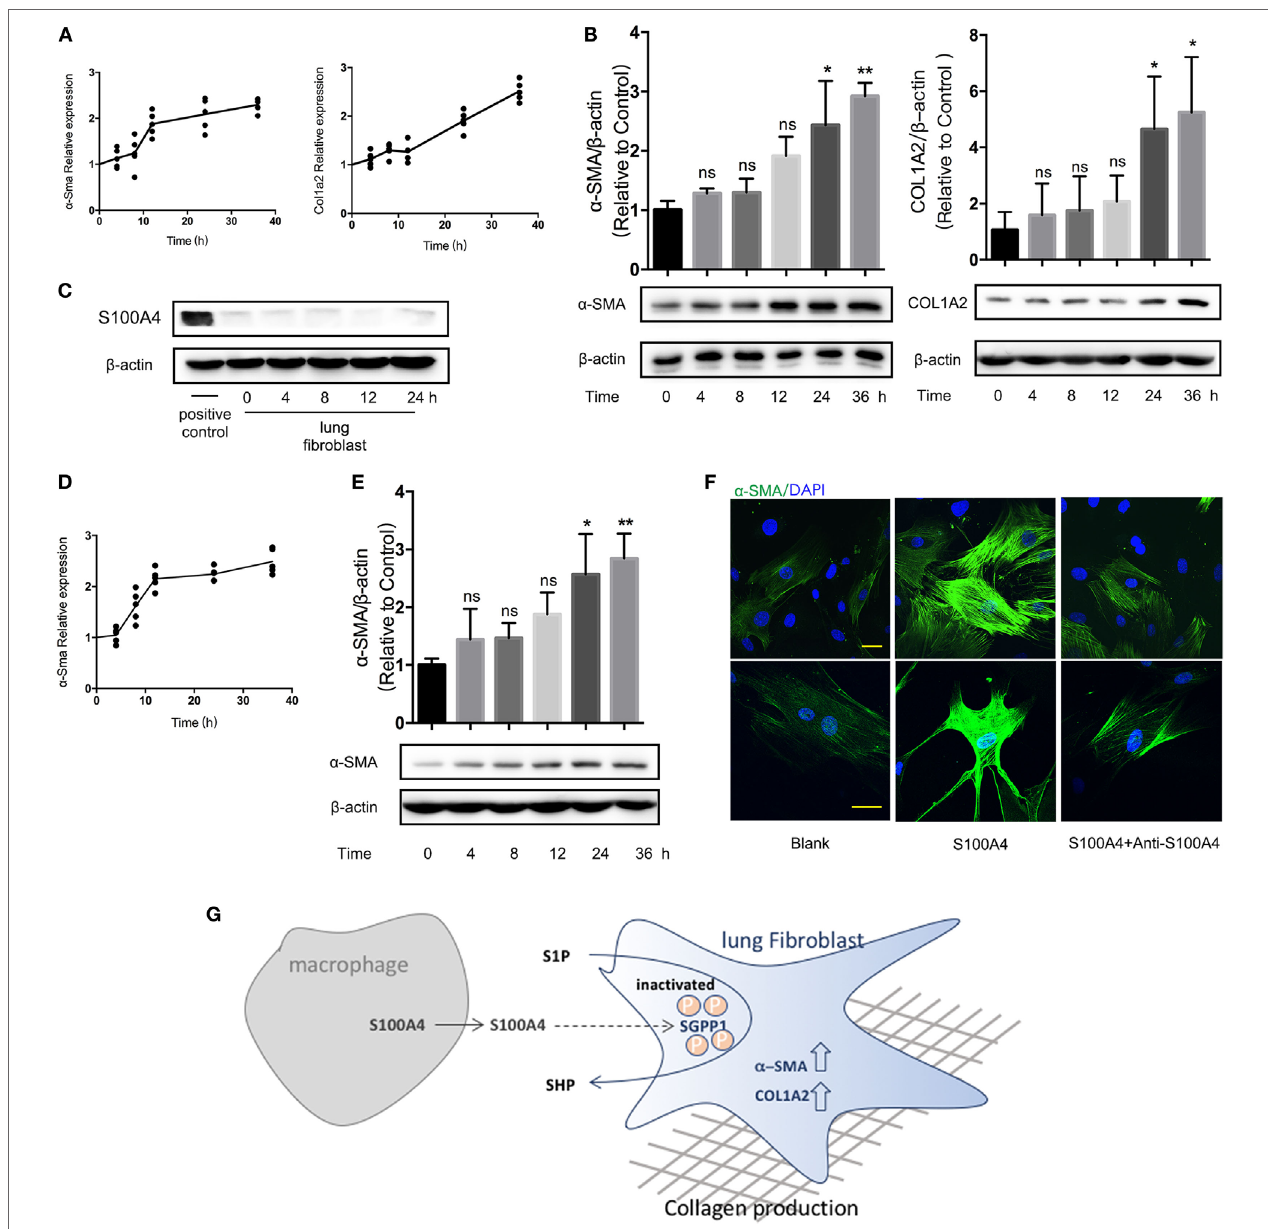
FigUre 6 | Extracellular S100A4 functions are confirmed in human lung fibroblasts. (a,B) Cells of the human lung fibroblast cell line MRC-5 were treated in vitro with recombinant S100A4 (1 µg/ml) for up to 36 h. Three independent cell-culture experiments with n = 5 cultures per group and experiment. (a) mRNA levels of ASMA and COL1A2 were analyzed by real-time PCR in relation to GAPDH . Mean values of relative expression over time in treated cultures as normalized to the control without S100A4. (B) α -SMA and COL1A2 protein levels were determined by western blot analysis as described for Figure 3c . Representative blots and mean ± SEM, * p < 0.05 and ** p < 0.01, Kruskal–Wallis. (c–F) Freshly isolated human primary lung fibroblasts were treated ex vivo with recombinant S100A4 (1 µg/ml) for up to 36 h. Three independent cell-culture experiments with n = 5 cultures per group and experiment. (c) S100A4 protein within the lung fibroblasts was detected by western blot analysis over time. RAW264.7 cells served as positive control. (D,e) mRNA and protein levels of ASMA were quantified as described for panels (a,B) . (F) Human lung fibroblasts treated with or without recombinant S100A4 and/or anti-S100A4 as indicated for 36 h were stained for α -SMA (green) by immunofluorescence. Representative images from two cultures per treatment group, scale bar, 25 µm. (g) Schematic summary for a role of S100A4 released by macrophages in activating of lung fibroblasts through an S1P-dependent upregulation of α